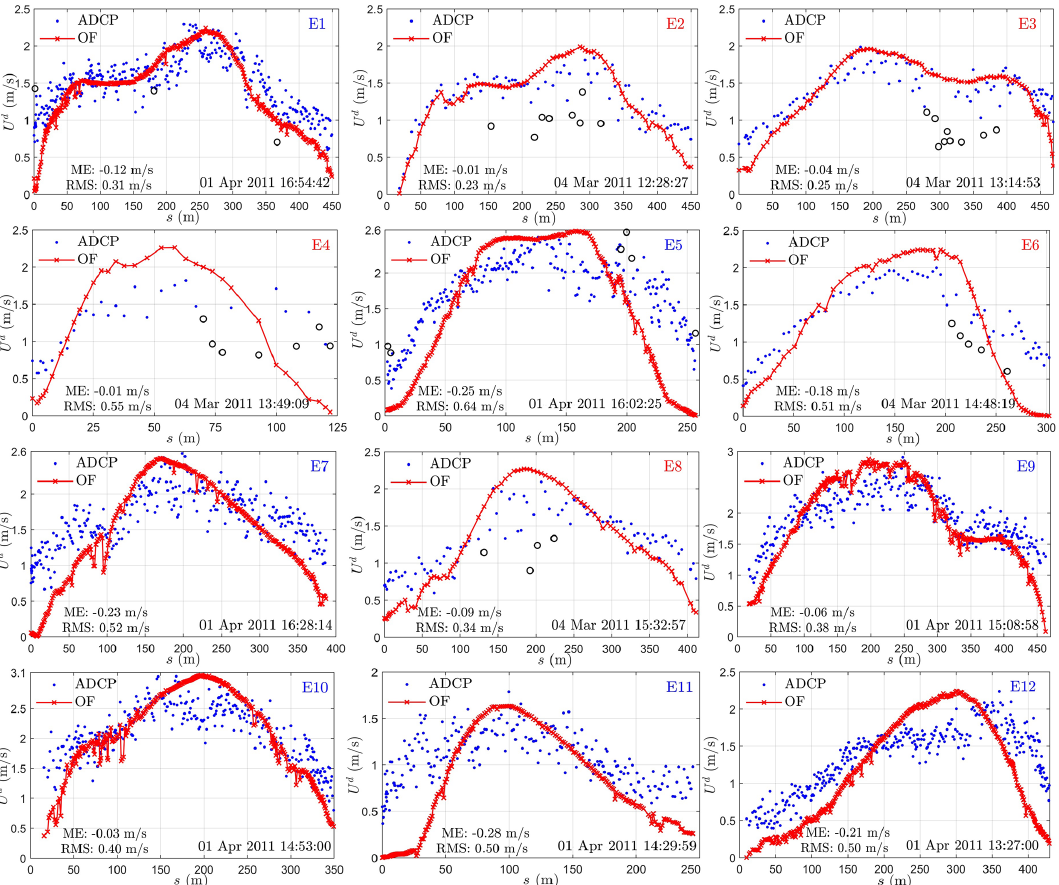
Figure 8. The comparison of depth-averaged velocity magnitude determined from ADCP surveys and CFD modeling. Black circles denote measured velocity outliers visually determined through velocity components (Figs. A5 or